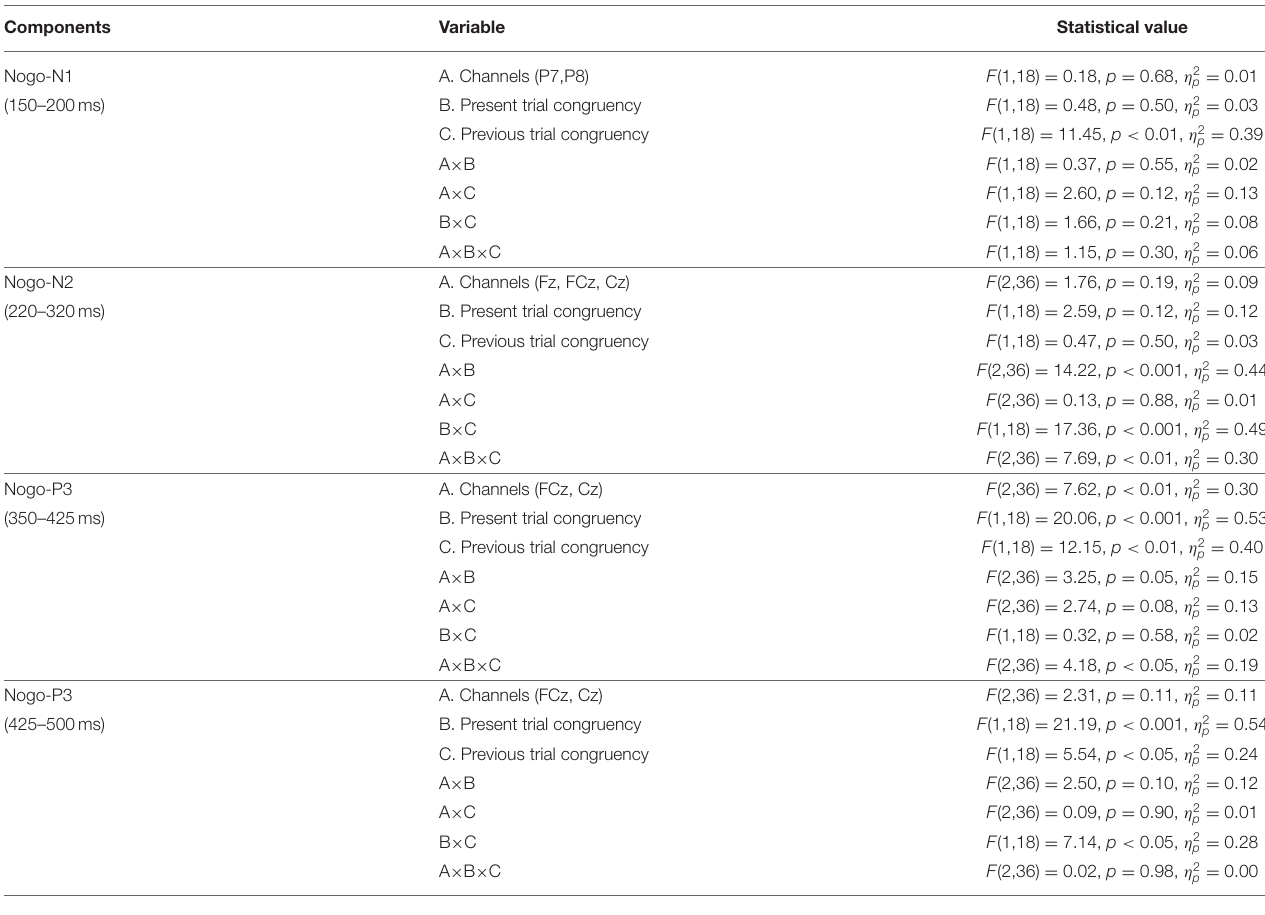
TABLE 4 | The results of ANOVA of ERP components for Nogo-stimuli. Components